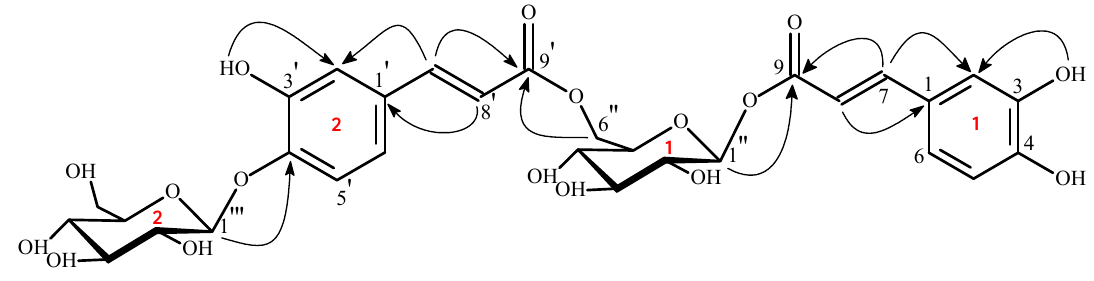
Figure 2 . Important HMBC correlations (H → C) for Scrocaffeside A ( 1